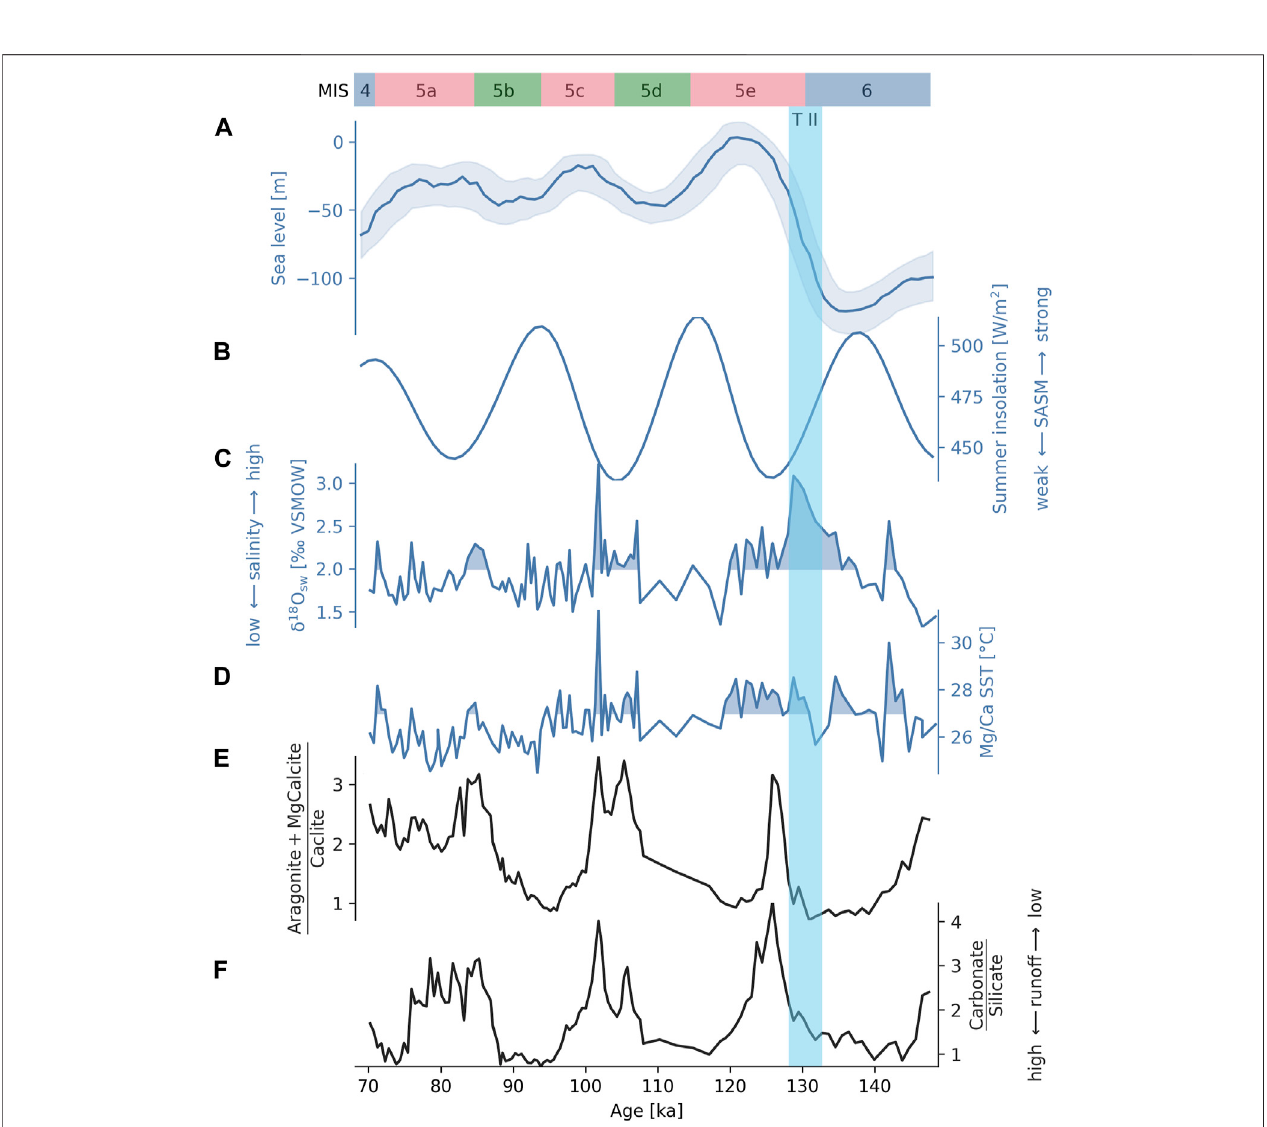
FIGURE 5 | Proportion of calcite phases compared to environmental proxies. (A) Sea level curve relative to today from Spratt and Lisiecki (2016). (B) Austral summer insolation curve at 20 ° S (Laskar et al., 2004). (C) Ice-volume-free seawater δ 18 O curve from Core M125-55 – 7 (Hou et al., 2020a). (D) Globigerinoides ruber (pink) Mg/Ca SST from Core M125-55 – 7 (Hou et al., 2020b). (E) Relation of the carbonate phases aragonite and Mg-calcite to calcite. The ratio is intensifying the carbonate trends seen in the bulk sediment record ( Figure 4I ), with aragonite and Mg-calcite being decreased and calcite being increased in high insolation phases. (F) ThecarbonatetosilicateratioindicatesthedischargeintensityoftheDoceRiver.Theremarkableco-variabilityofcarbonatephaseproportionsanddischarge indicates that the riverine in fl ux impacts themarineenvironmental conditions. High discharge seemed tobe more pro fi tablefor calcitic organisms while in times ofhigher evaporation, indicated by high temperatures and salinities, aragonitic and Mg-calcitic organisms dominate the carbonate production.